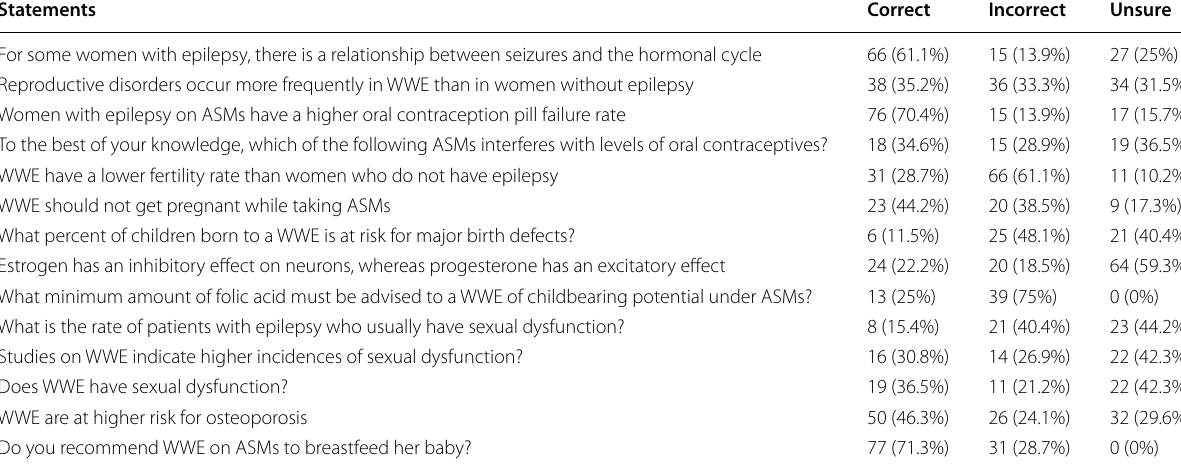
Table 1 Knowledge and awareness of health issues for women with epilepsy